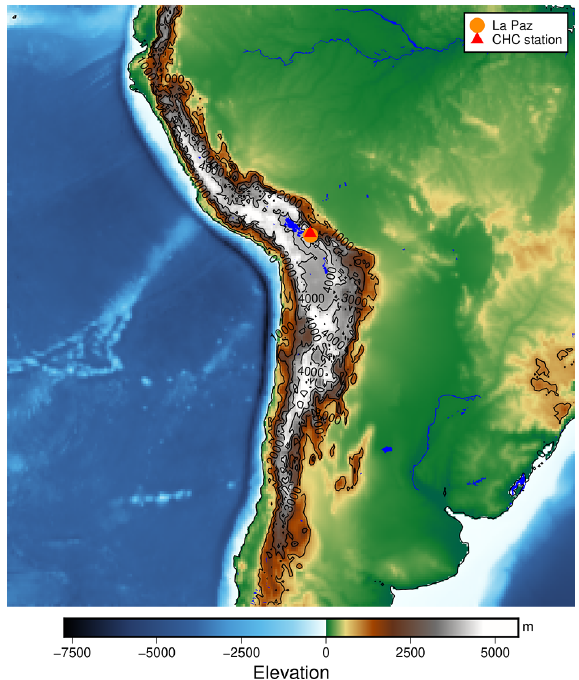
Figure B1. The location of the Chacaltaya Global Atmosphere Watch (GAW) station in the Bolivian Andes. The elevation data shown are taken from Tozer et al. (2019).